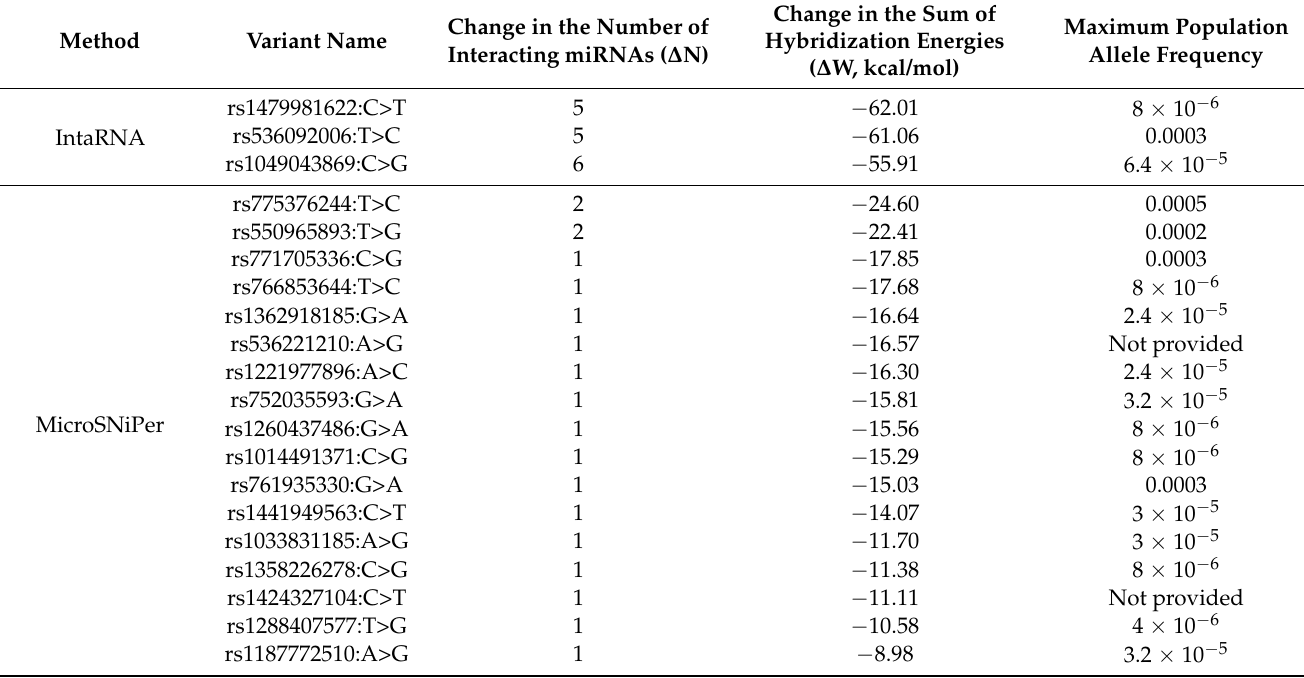
Table 1. The most effective variants predicted to downregulate the DROSHA expression in mesenchymal stromal cells